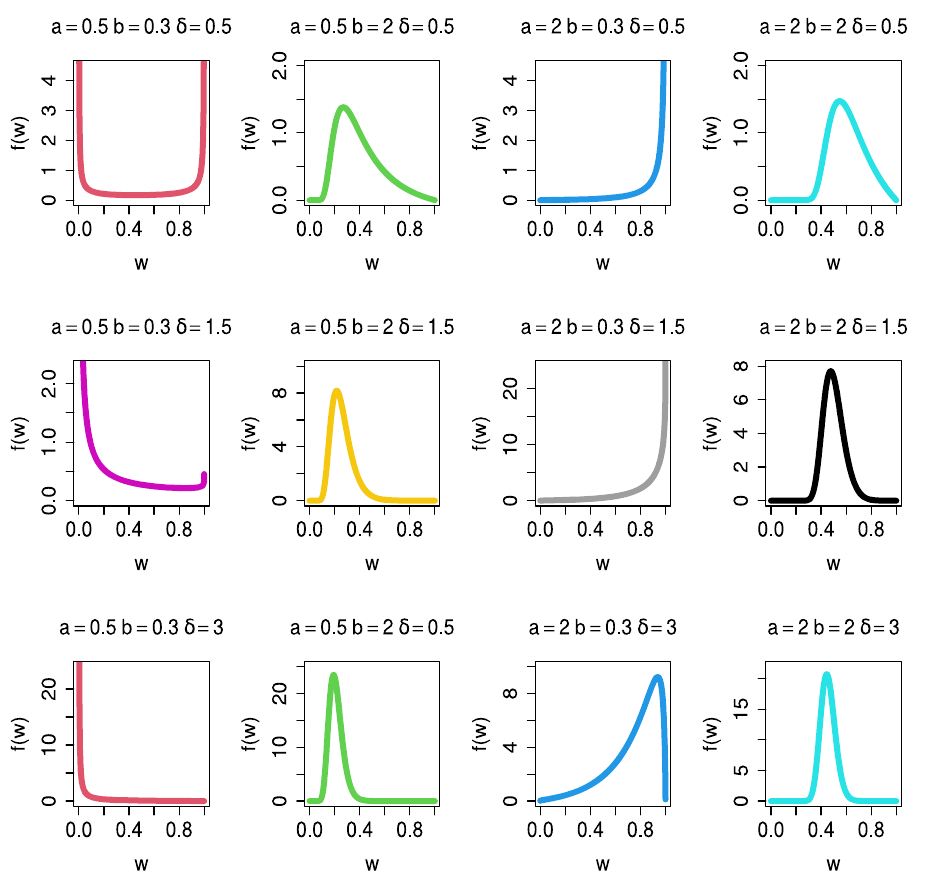
Axioms 2023 , 12 , x FOR PEER REVIEW Figure 1. Plots of various PDF shapes of the UPBXD for different parameter values. Figure 1. Plots of various PDF shapes of the UPBXD for di ff erent parameter values.